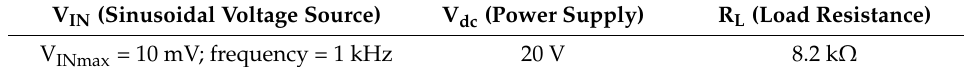
Table 2. Values of the load resistance and the voltage sources of the circuit. V IN (Sinusoidal Voltage Source)